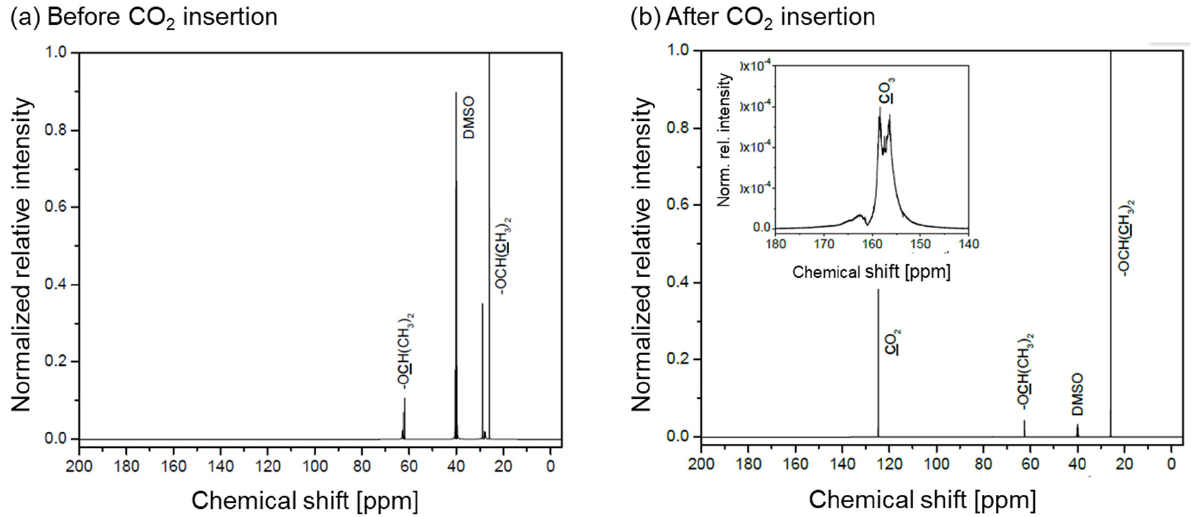
Figure 4. ( a ) 13 C-NMR spectrum of Mg[Al(O i Pr) 4 ] 2 dissolved in d 6 -DMSO before CO 2 insertion. ( b ) 13 C-NMR spectrum of Mg[Al(O i Pr) 4 ] 2 dissolved in d 6 -DMSO after CO 2 insertion. The signal at 125 ppm can be attributed to dissolved CO 2 .